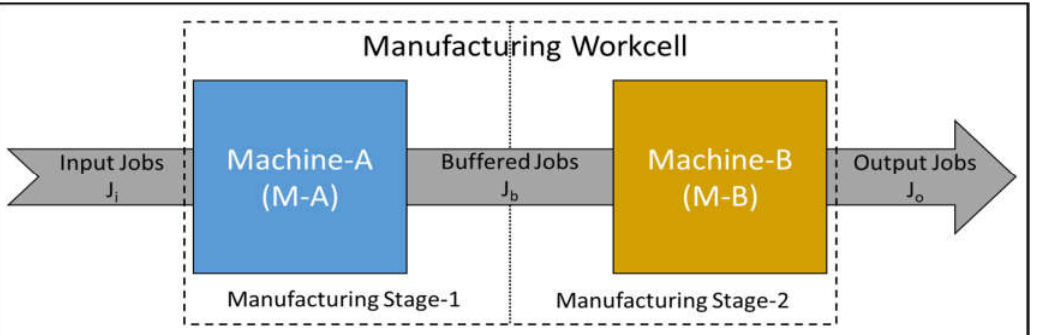
Figure 1. Model of two sequential stages manufacturing workcell.